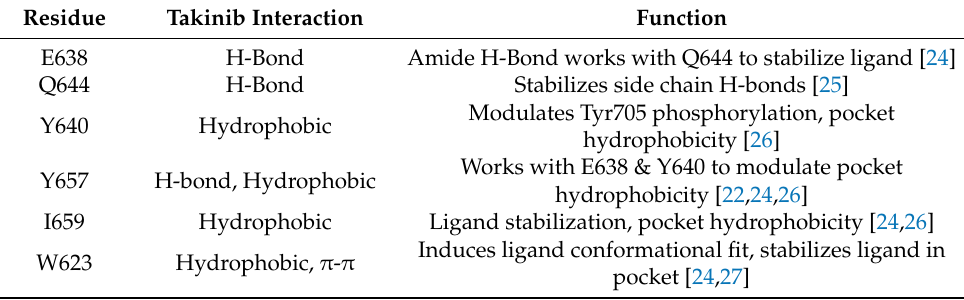
Table 1. Predicted takinib/STAT3 Binding Interactions and Known STAT3 Residue